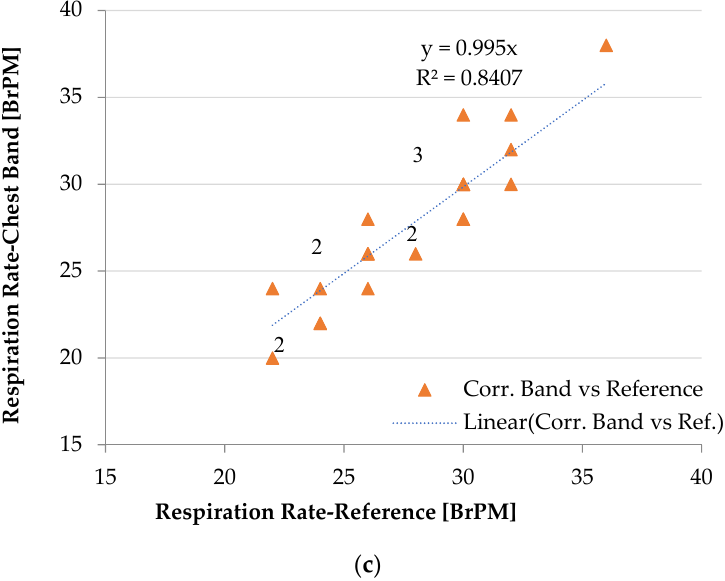
Figure 10. Correlation diagrams of RR measurements obtained by the developed piezoresistive chest band and counting the number of breaths, considering three different operating conditions: seated user ( a ), standing user ( b ), and user walking at 1 ms − 1 ( c ). The multiplicity of the data points is indicated in the graph.